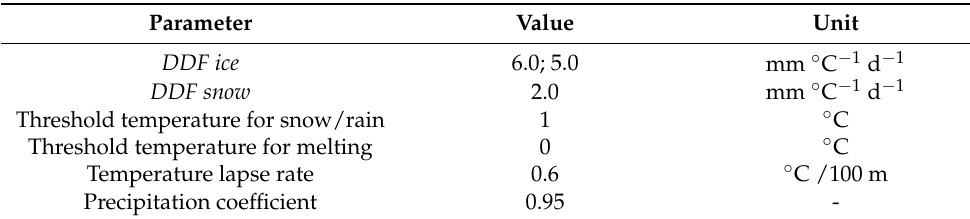
Table 2. Model parameters used for mass-balance